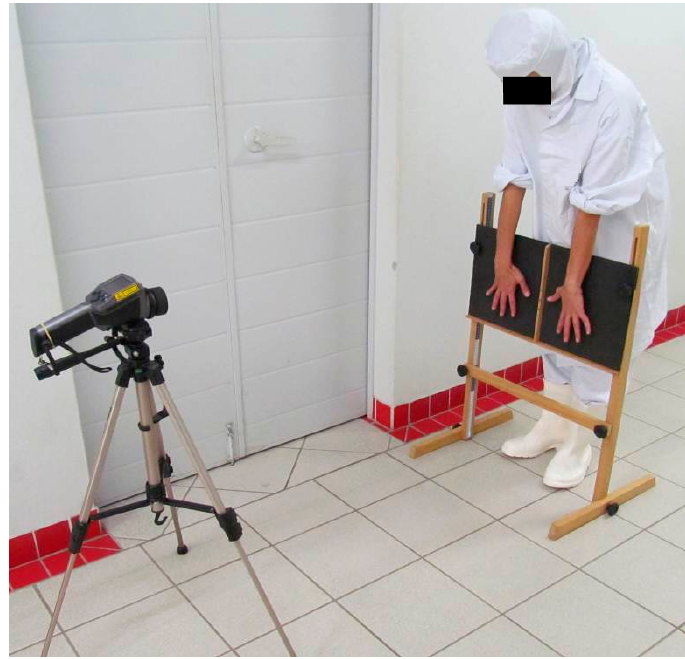
Figure 1. Infrared portable camera and frame for capturing the thermographic images.